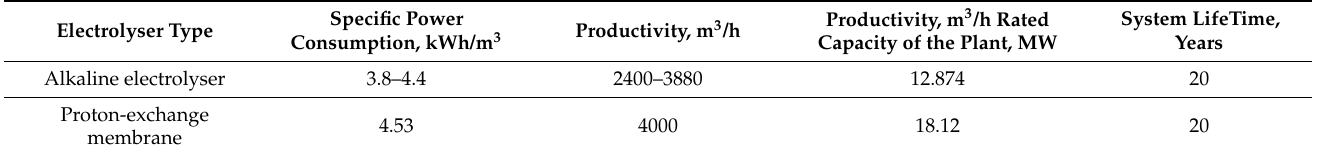
Table 3. Characteristics of different types of